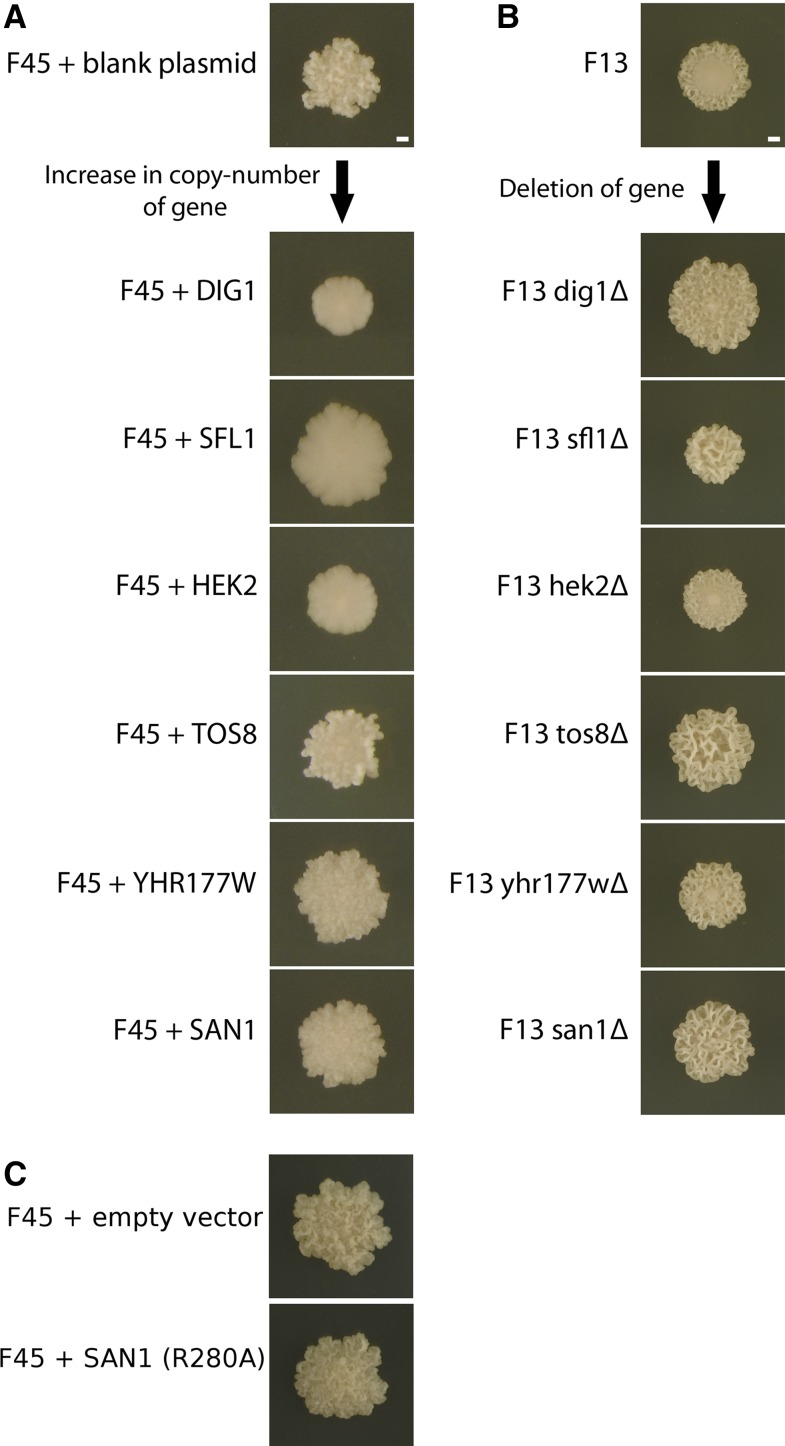
Effects of overexpressing and deleting genes identified in screen for modulators of the fluffy phenotype. (A) Increase in copy number of DIG1, SFL1, HEK2, ROF1/YHR177W, SAN1, and TOS8 leads to a reduction in fluffy morphology in strain F45, grown on YPD with 2% glucose. (B) Deletion of DIG1, SFL1, HEK2, ROF1/YHR177W, SAN1, and TOS8 leads to an increase in fluffy morphology in strain F13, grown on YPD with 1% glucose. (C) When the catalytically dead san1-R280A allele is overexpressed in F45, colonies remain fluffy.